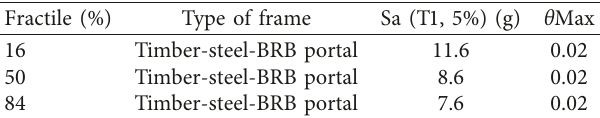
Table 12: Summarized capacity of the timber-steel-BRB portal frame for immediate occupancy (IO) limit